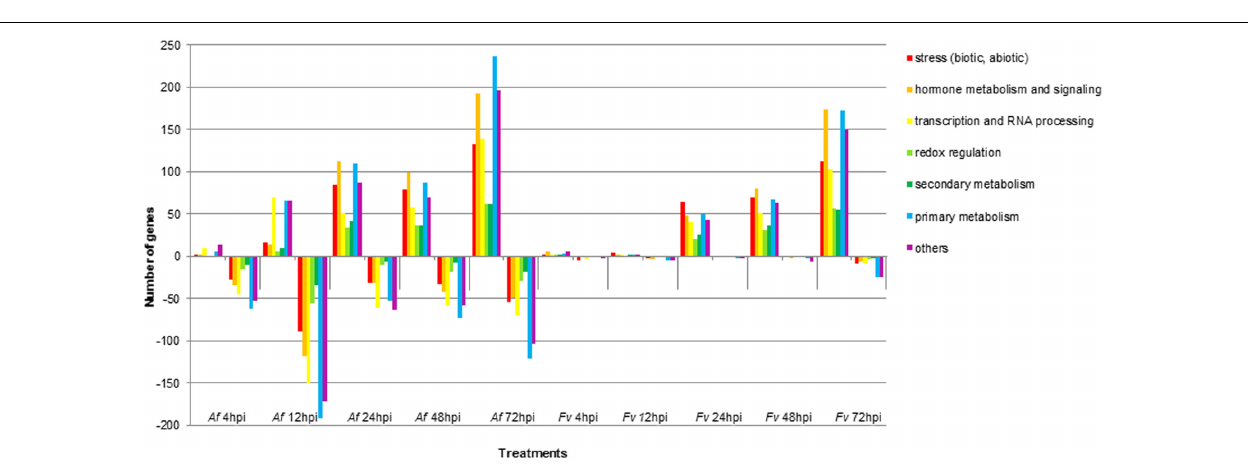
FIGURE 3 | Functional categories of maize genes differentially regulated upon infection by A. flavus ( Af ) and F. verticillioides ( Fv ) at different time points. Colored bars represent the numbers of regulated genes with annotated function. Positive bars denote numbers of up-regulated genes. Negative bars denote numbers of down-regulated